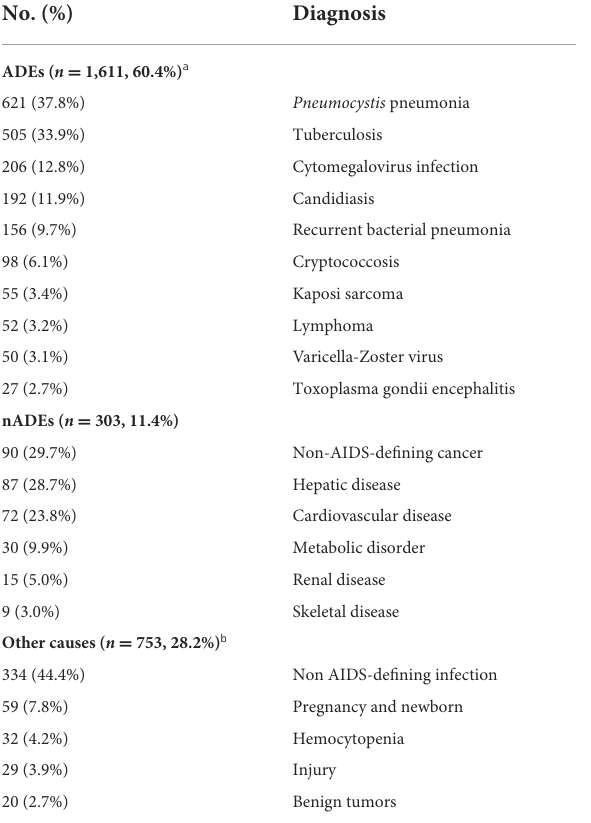
TABLE 3 Distribution of discharge diagnoses for 2,667 hospitalizations among 9,404 patients.